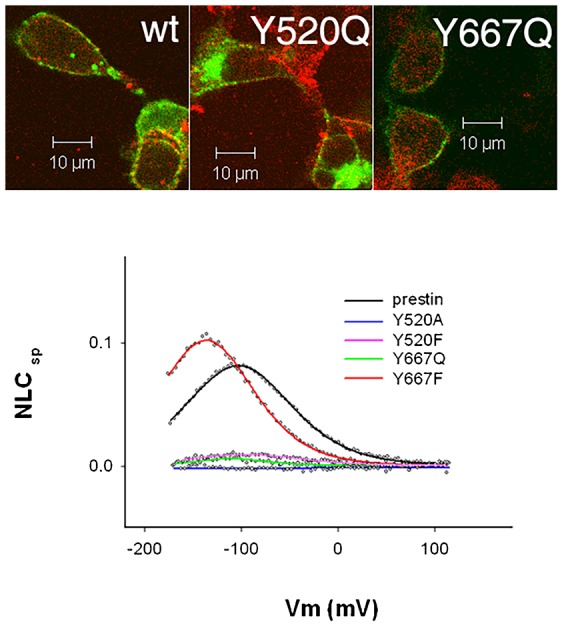
Mutation of Y520Q and Y667Q results in targeting of prestin to the plasma membrane of HEK cells, and presence of NLC in Y667Q, Y520F and Y667F.The upper panels show HEK cells transfected with wild type prestin-YFP, and the two constructs Y520Q prestin YFP, and Y667Q prestin YFP that were fixed 48 hours after transfection. Cells were stained with antibodies to Na/K ATPase and visualized by confocal microscopy. Wild type prestin YFP, Y520Q prestin YFP and Y667Q prestin YFP all target the plasma membrane as evidenced by its co-localization with plasma membrane Na/K ATPase. The lower panel shows NLC traces of different mutations at Y520 and Y667. The actual values of NLC parameters along with cell numbers are given in supplementary material Table S1. The scale bar is 10 microns.